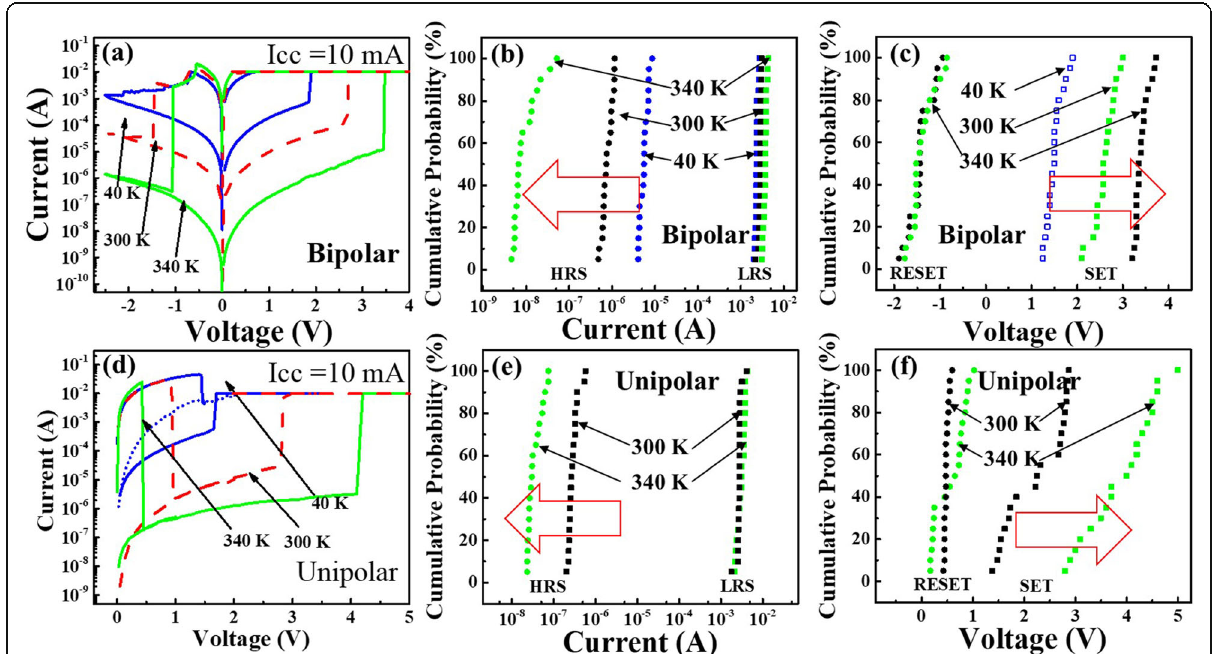
Fig. 5 a The I-V curves of the bipolar behaviour at different temperatures (40 K (blue line), 300 K (red dashed line) and 340 K (green line)) with a compliance current Icc = 10 mA. b Statistical result of the HRS and LRS current for 20 bipolar switching cycles at different temperatures (40 K, 300 K and 340 K). c Statistical result of the SET and RESET voltage for 20 bipolar switching cycles at different temperatures (40 K, 300 K and 340 K). d The I-V curves of the unipolar behaviour at different temperatures (40 K (blue line), 300 K (red dashed line) and 340 K (green line)) with a compliance current Icc = 10 mA. The blue dotted line indicates the next set process after the reset operation. e Statistical result of the HRS and LRS current for 20 unipolar switching cycles at different temperatures (300 K and 340 K). f Statistical result of the SET and RESET voltage for 20 unipolar switching cycles at different temperatures (300 K and 340